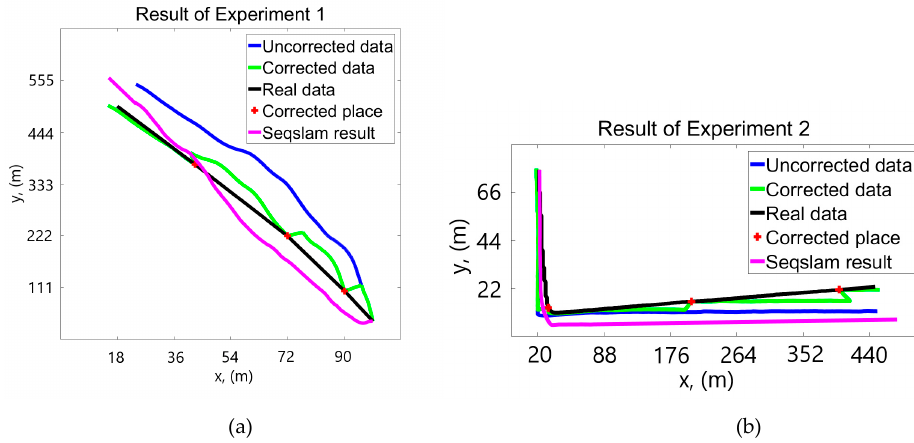
Figure 17. Experimental results and the comparison of different navigation schemes. (a) Comparisons of algorithmic results in experiment 1. (b) Comparisons of algorithmic results in experiment 2.